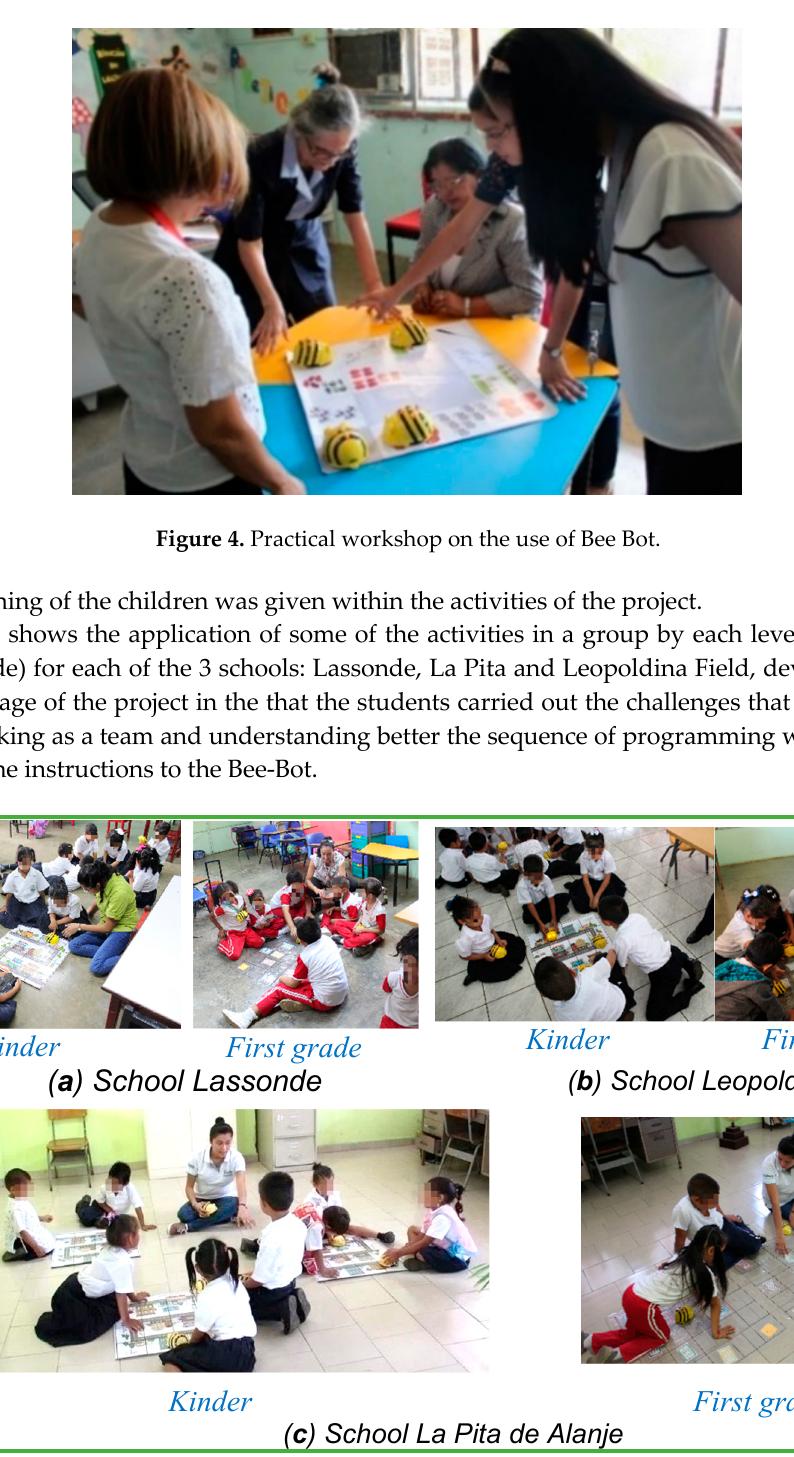
Figure 5. Practical workshop on the use of Bee Bot with